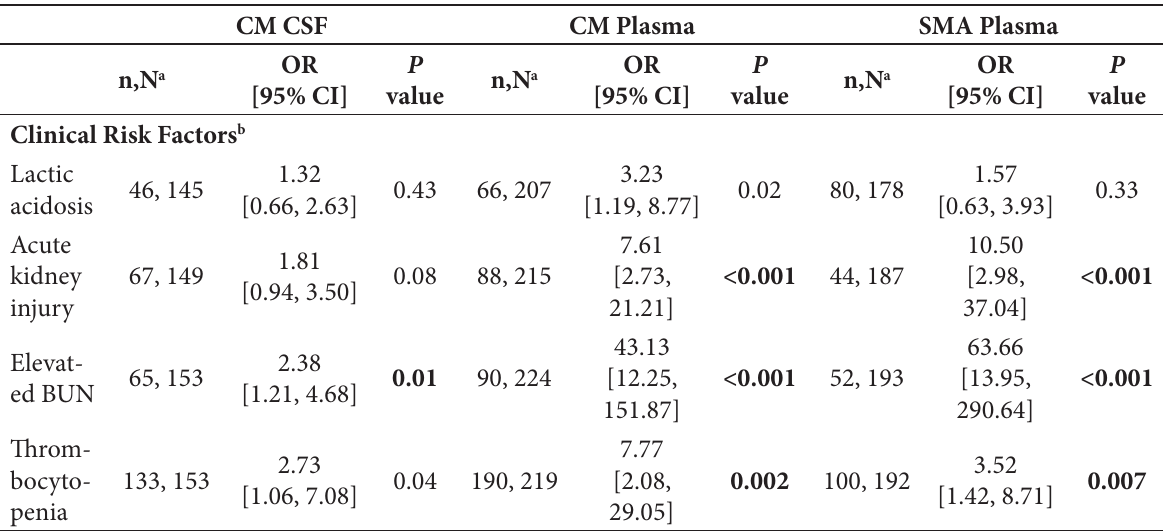
Table 3. Association between plasma and CSF levels of sST2 to clinical risk factors in children with cerebral malaria (CM) or severe malarial anemia